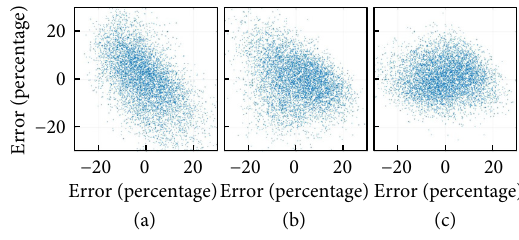
Fig. 14 Federated learning errors of currents’ real parts (x-axis) and imagi- nary parts (y-axis) for microgrid 2’s ( a ) phase , ( b ) phase , and ( c ) phase .